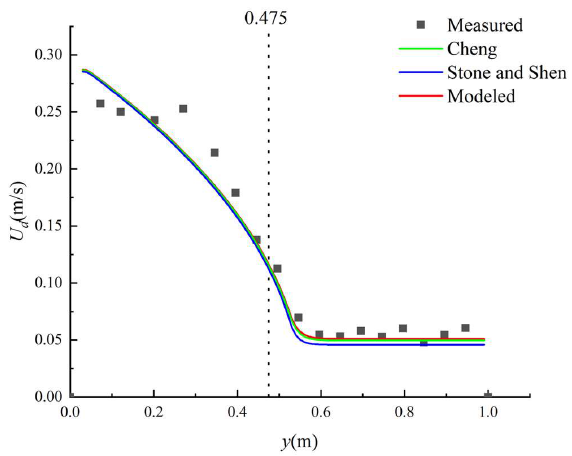
Figure 4. Water depth-averaged streamwise velocity between the experimental data and analytical solution in case 3. ϕ 1 = 0.3044, ϕ 2 = 0.6107, and ϕ 3 = 0.4318.